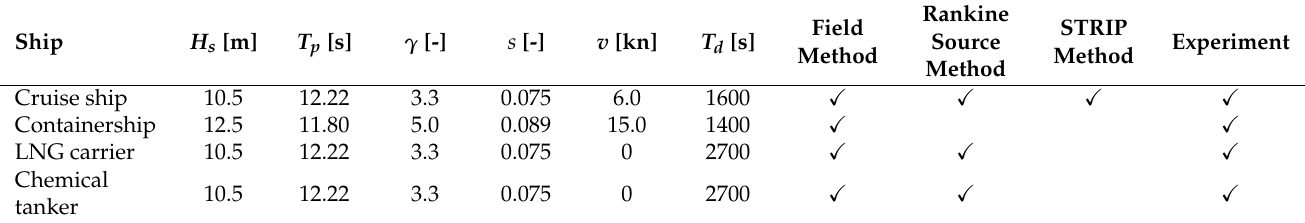
Table 4. Parameters of investigated irregular sea states and applied